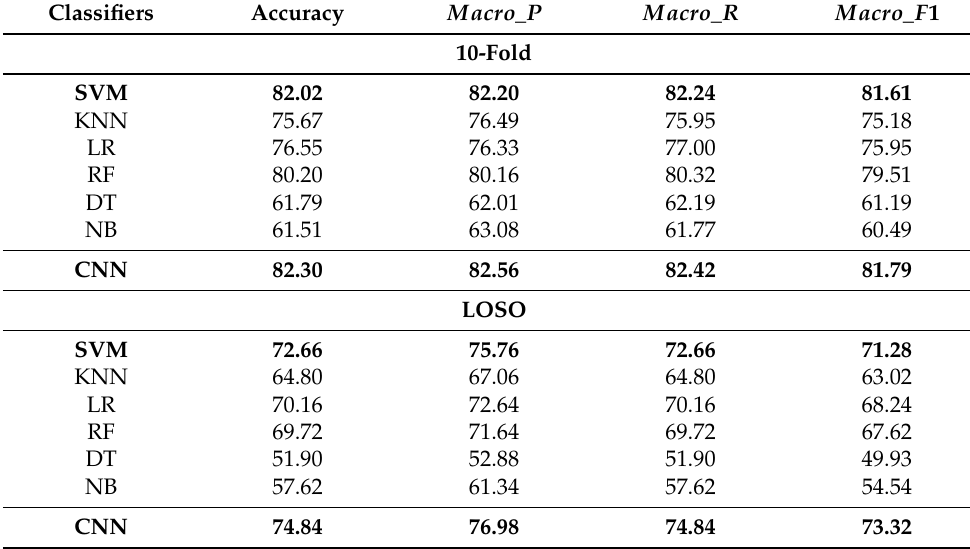
Table 5. The results (in %). The classical machine learning classifiers use the results after all the preprocessing methods and features extraction described in Section 4 as input, while the CNN model uses raw samples as input. The best classifier and all best results are